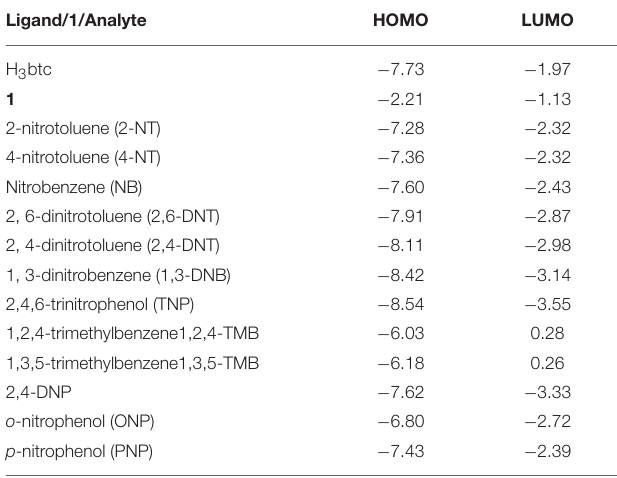
TABLE 1 | The HOMO-LUMO energies (in eV) for 1, ligand and aromatic analytes, ligand. Ligand/1/Analyte